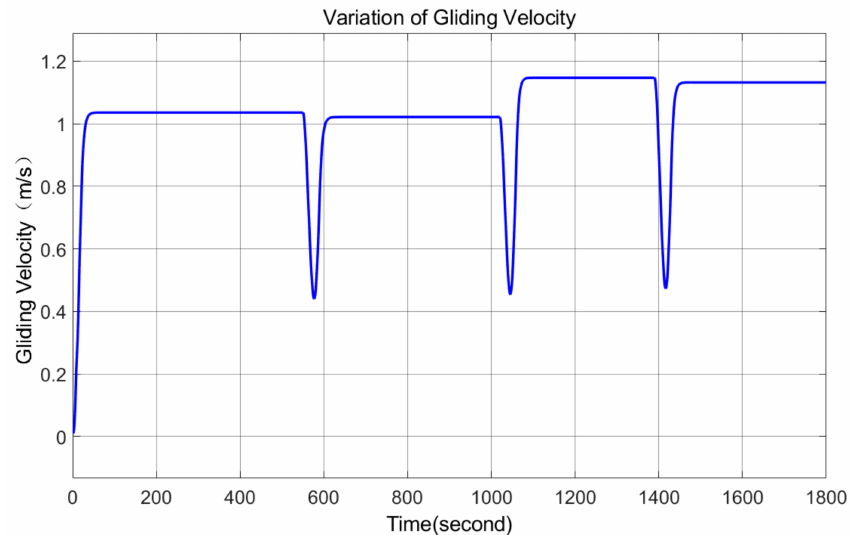
Figure 14. Gliding speed during